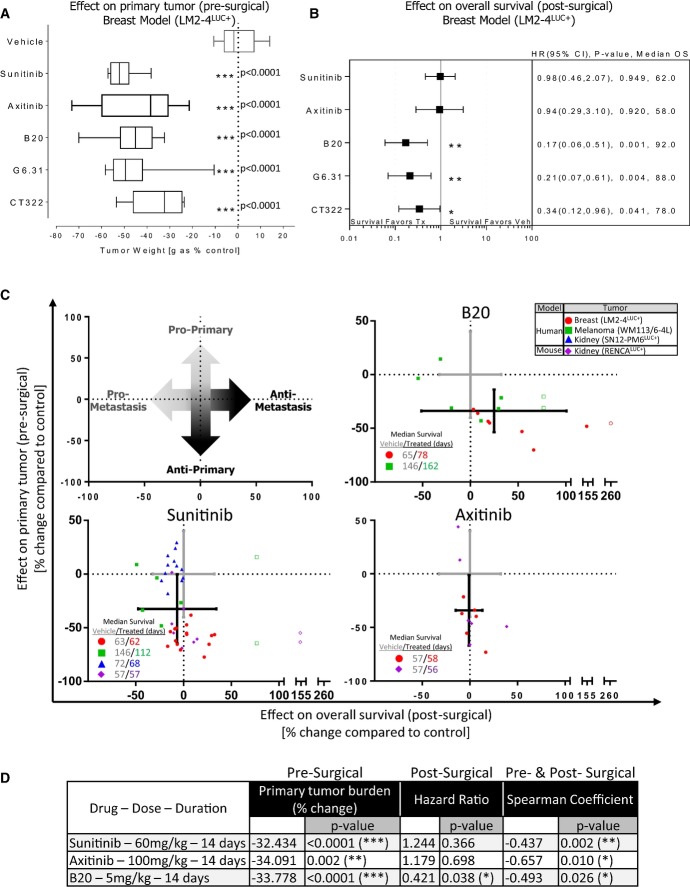
Pre-surgical effects of neoadjuvant protein-based VEGF pathway inhibition predict for
improved post-surgical survival in multiple metastasis modelsComparison of excised orthotopic LM2-4LUC+ breast tumor weights
following 14-day neoadjuvant therapy with VEGF RTKIs (sunitinib or axitinib), protein-based
neutralizing antibodies to VEGF (G6.31 or B20), or a VEGFR-2 blocking adnectin (CT322).Forest plot summary of post-surgical Cox regression survival analysis following neoadjuvant
treatment cessation for groups described in (A).Combined analysis of pre- and post-surgical effects to assess effects on primary tumor and
metastatic growth following 14 days of neoadjuvant treatment with sunitinib, axitinib, or
B20. Models include LM2-4LUC+ (red circle), WM113/6-4L (green square),
SN12-PM6LUC+ (blue triangle), and
RENCALUC+ (purple diamond).Corresponding values for primary tumor burden, survival hazard ratio, and Spearman coefficient
analysis (see Materials and Methods for details).Data information: Symbols and bars for box and whiskers plot: median (line), upper/lower
quartile (box), min/max (error bars). Survival analysis: hazard ratio (HR), confidence interval
(CI), overall survival (OS) based on Kaplan–Meier or Cox regression analysis.
N = 6–15 mice per group. Treatment (Tx), vehicle
control (Veh). Open symbols were used to indicate data points from animals that were still alive
when the experiments were terminated. Crossed lines represent the standard deviation of the
vehicle-treated (gray cross) and drug-treated (black cross) from primary tumor burden data (vertical
line) and median survival data (horizontal line).
*P < 0.05,
**P < 0.01,
***P < 0.001 compared to control.